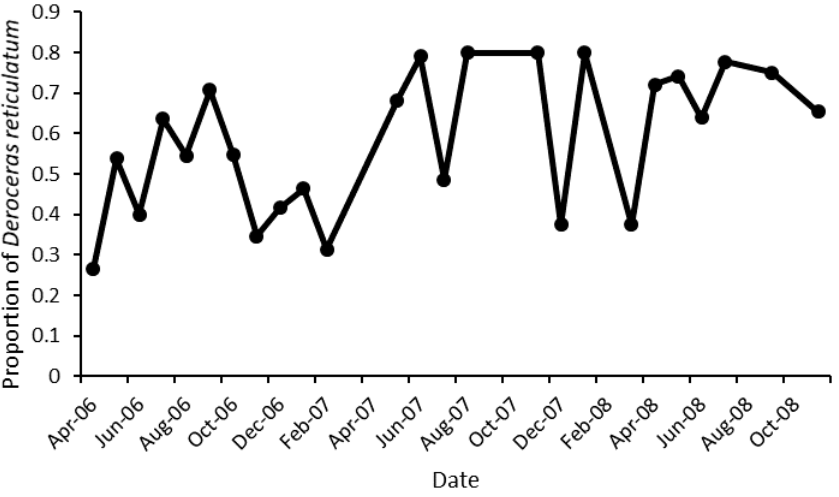
Figure 2. The proportion of Deroceras reticulatum in slug species collected from traps at a grassland site over 32 months.